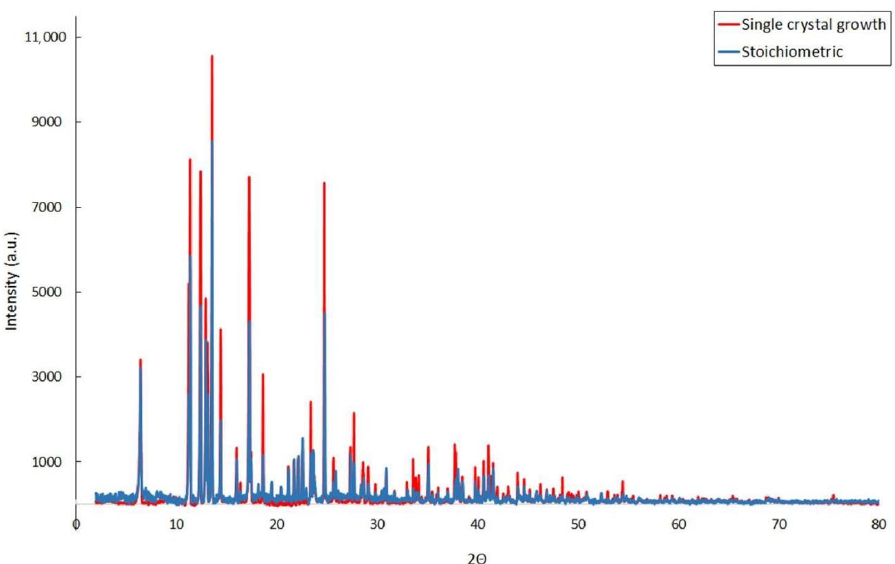
Figure 9. Superimposition of the PXRD pattern for [Cu 2 (μ -OAc) 4 ( 1 )] n obtained from a preparative scale reaction (blue) and from the single-crystal growth experiment (red).